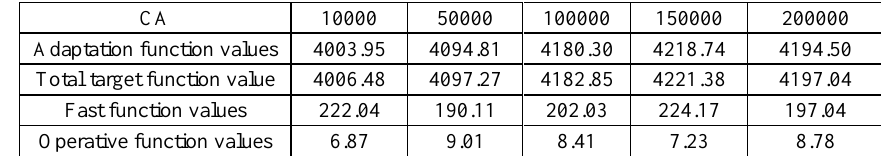
Table 2 .The M 08 Chaos algorithm.